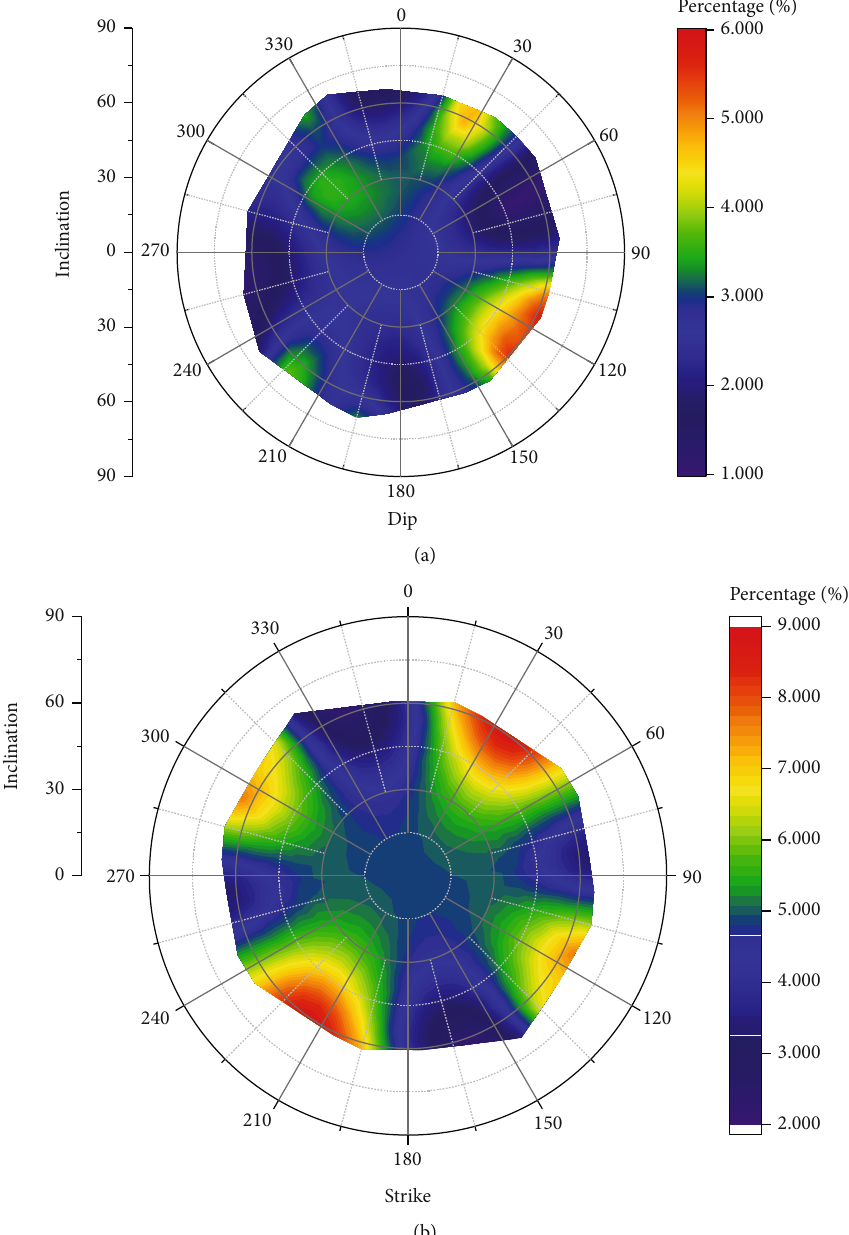
Figure 2: Pole density plot of dip and strike with inclination. (a) The dip angle of discontinuities; (b) the strike angle of